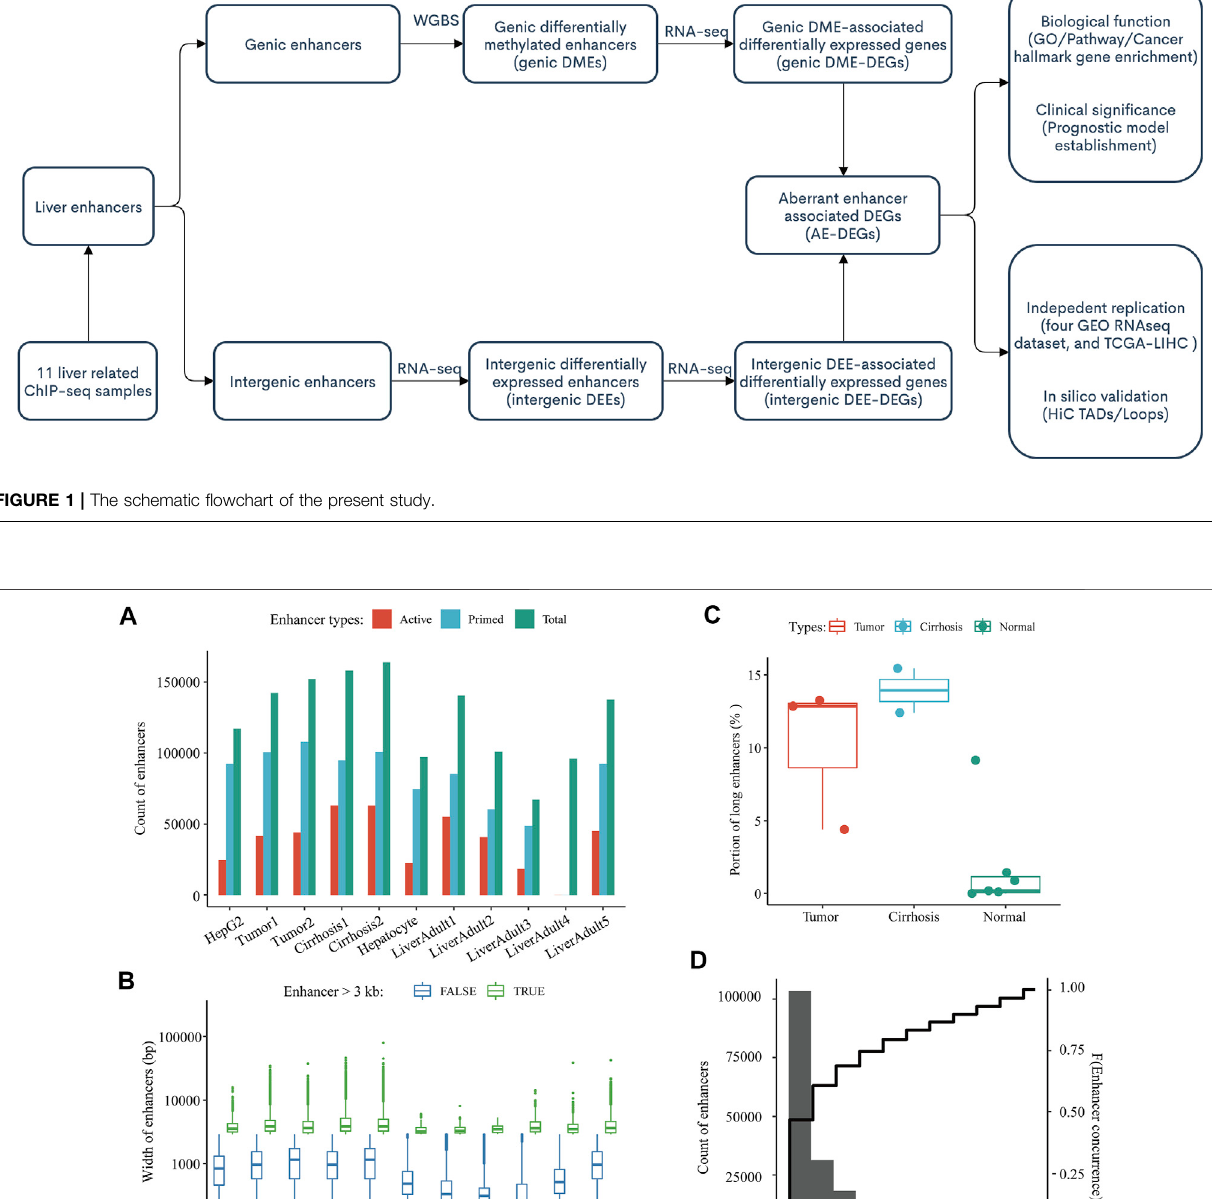
Frontiers in Cell and Developmental Biology |